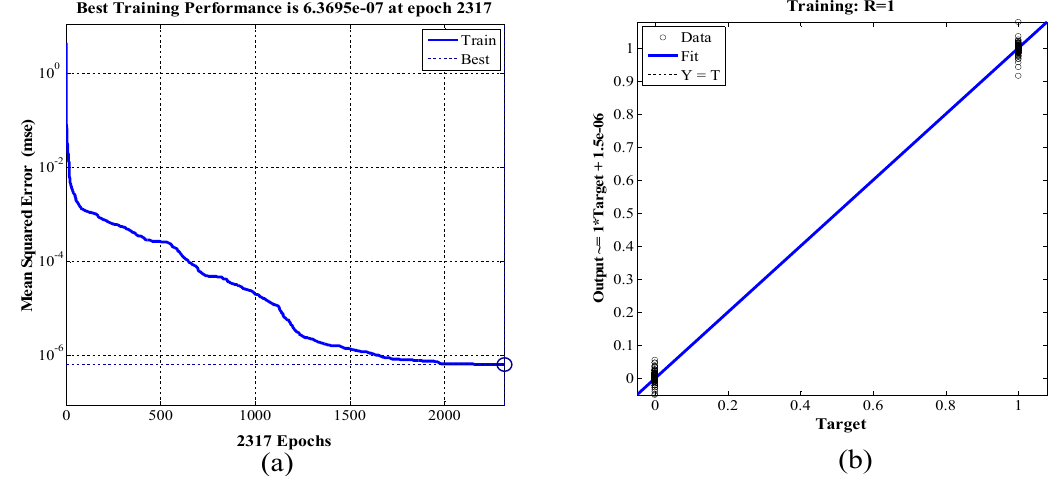
Figure 11. ( a ) Performance and ( b ) regression of ANN training after applying optimal parameters of ANN-BSA.